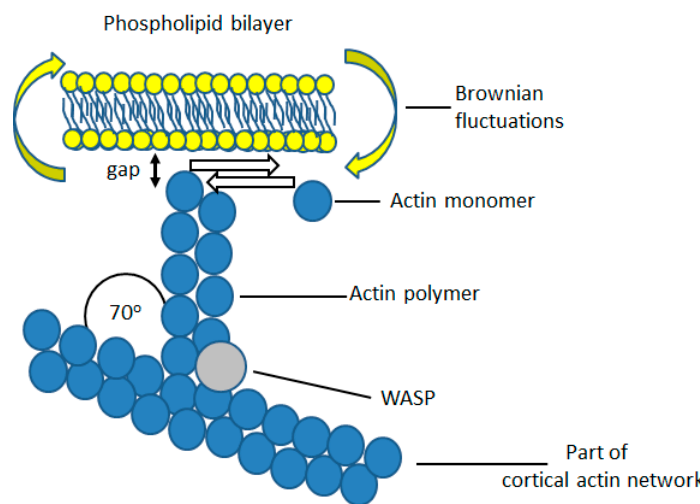
Figure 2. The Brownian ratchet for actin polymerisation near the plasma membrane. From the cortical actin network, branch points are formed by insertion of WASP protein which allows an additional point for another actin polymer to grow towards the plasma membrane. This actin polymer continues to grow until it encounters the plasma membrane and the gap between the polymer tip and the plasma membrane is less that the diameter of a single actin monomer. However, if there is slack in the membrane, Brownian fluctuations in the position of the plasma membrane will occur (as the membrane moves back and forth randomly) and the gap may transiently be greater than the diameter of an actin monomer. In which case, the actin polymer will grow and ‘push’ the membrane. The Brownian ratchet will continue until the tension in the plasma membrane increases to a point when Brownian fluctuations are so lessened that no gap which is greater than the actin monomer size can form between the actin polymer tip and the plasma membrane.